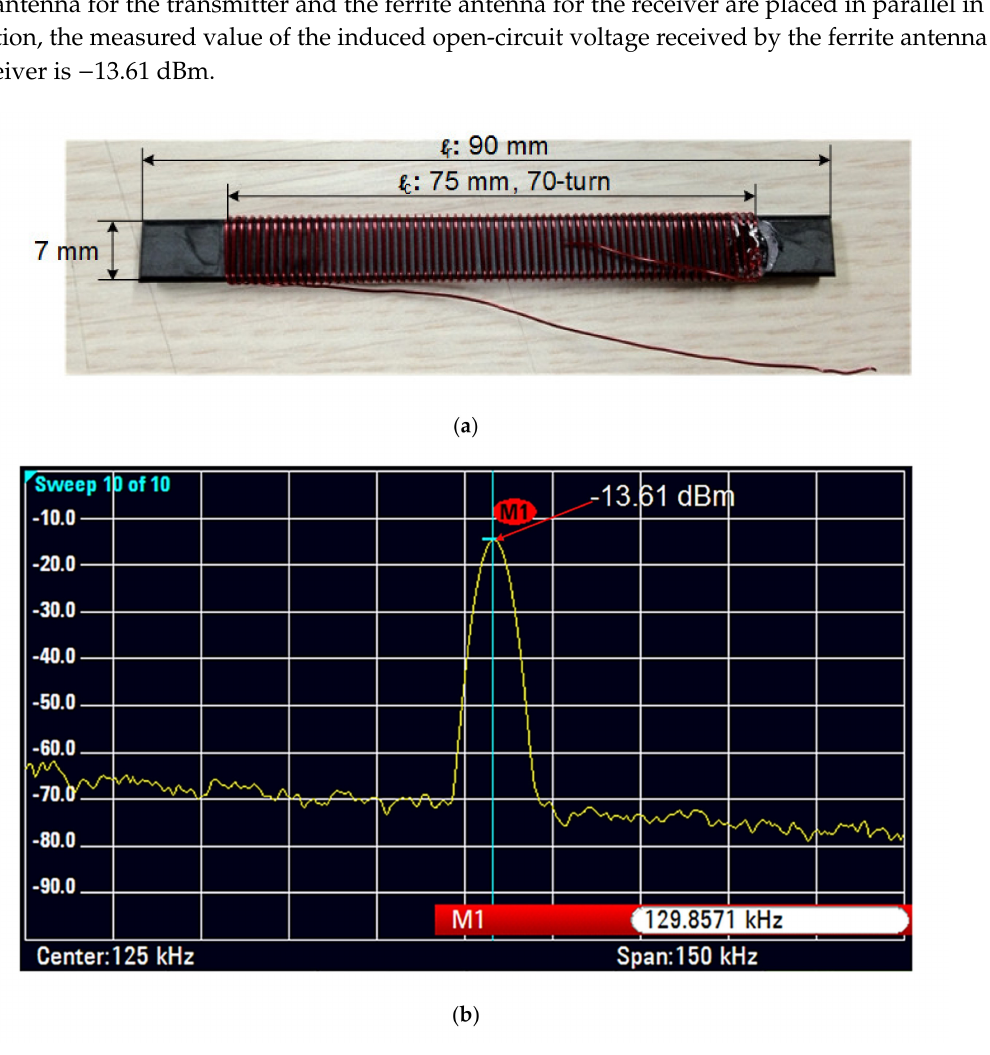
Figure 11. Experimental test of unit-level. ( a ) Ferrite antenna used for unit-level test; ( b ) experimental result is that x-direction is 0 mm, y-direction is 0 mm and z-direction is 8